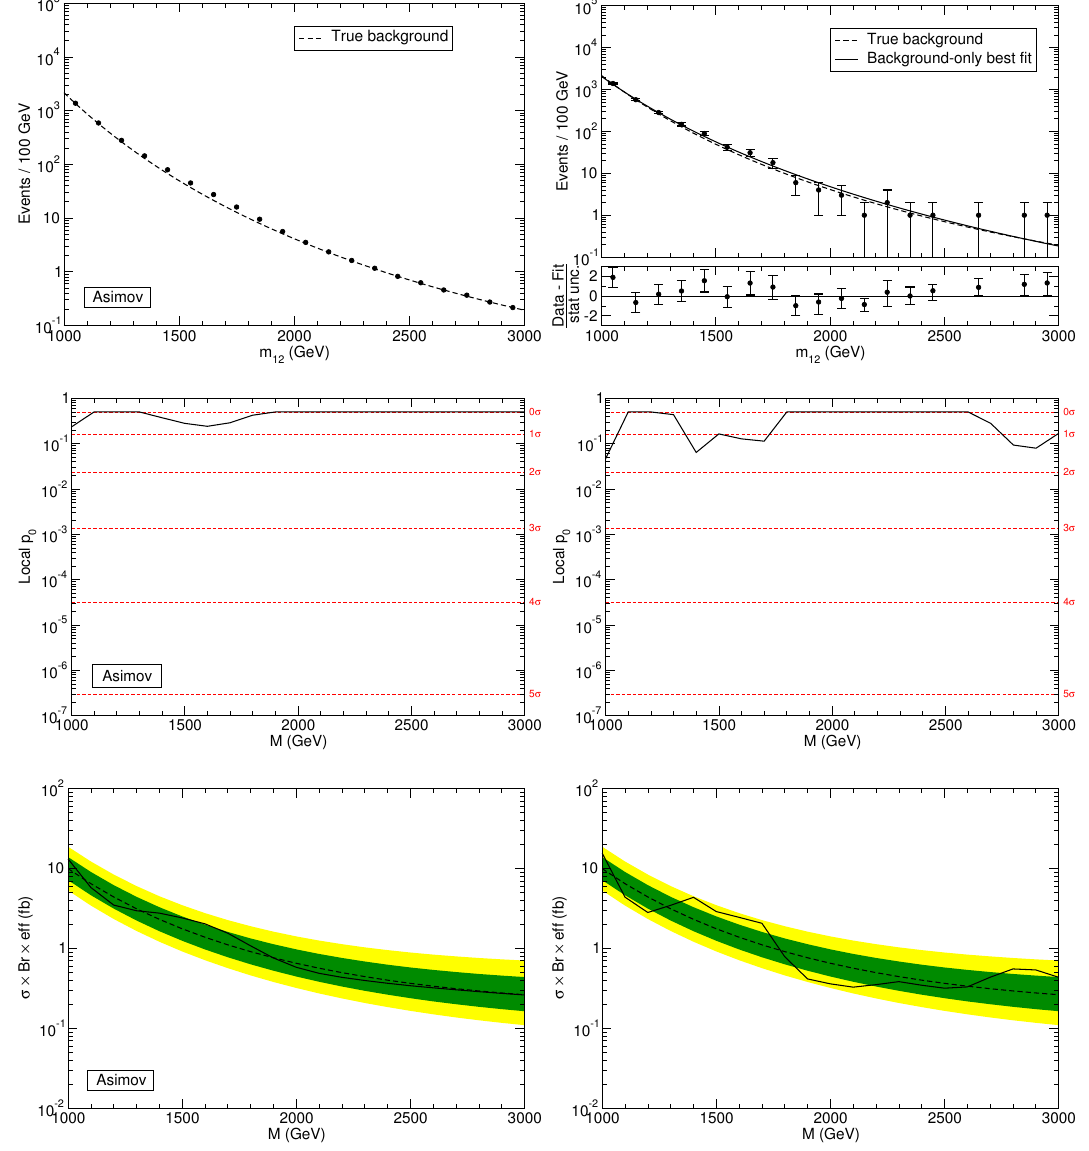
Figure 10 . Top, left: Asimov data for the quadriboson tail in (cid:12)gure 6, with a size of 100 signal events. Top, right: data for a pseudo-experiment. Middle, left: local p -values for the Asimov data. Middle, right: local p -values for the pseudo-experiment. Bottom, left: expected and observed limits for the Asimov data. Bottom, right: expected and observed limits for the pseudo-experiment.